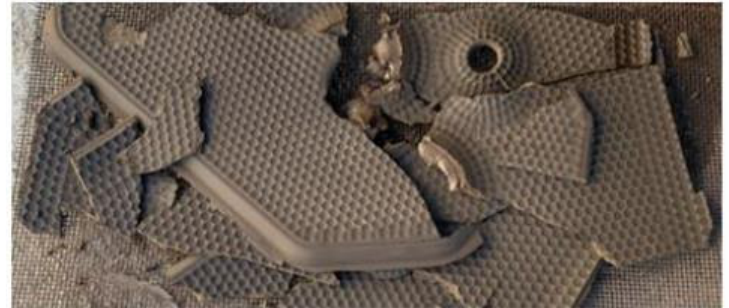
Figure 4. Press cake obtained with the membrane filter press during the long duration experiment.